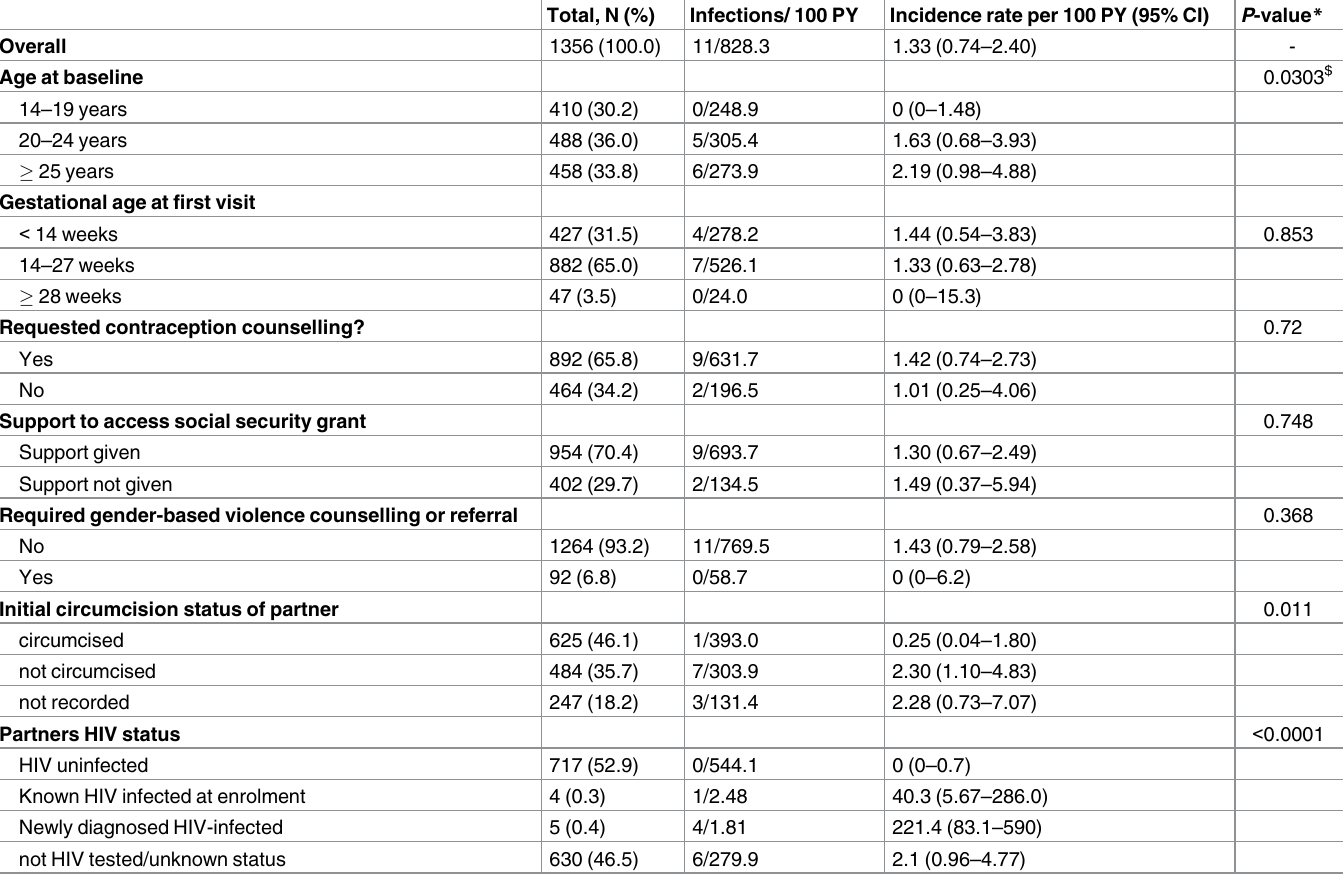
Table 1. Baseline characteristics and HIV incidence according to characteristics of pregnant women and their partners in South